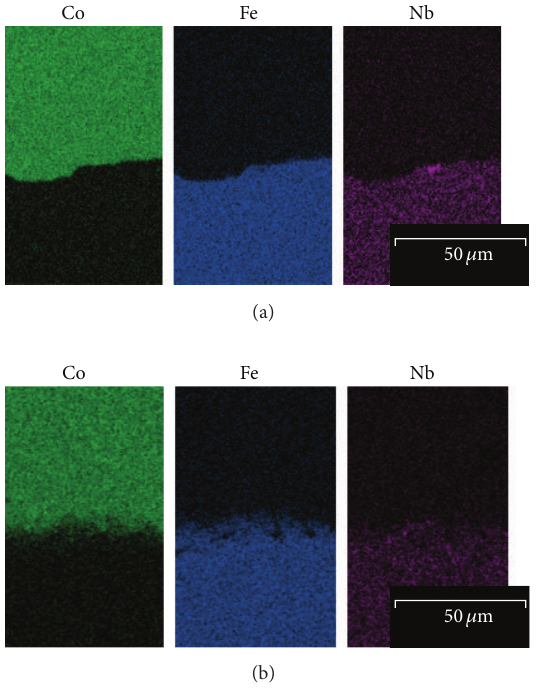
Figure 5: Element mapping differences in the interface character after EB treatment under HVOF-B (a) and HVOF-C (b)